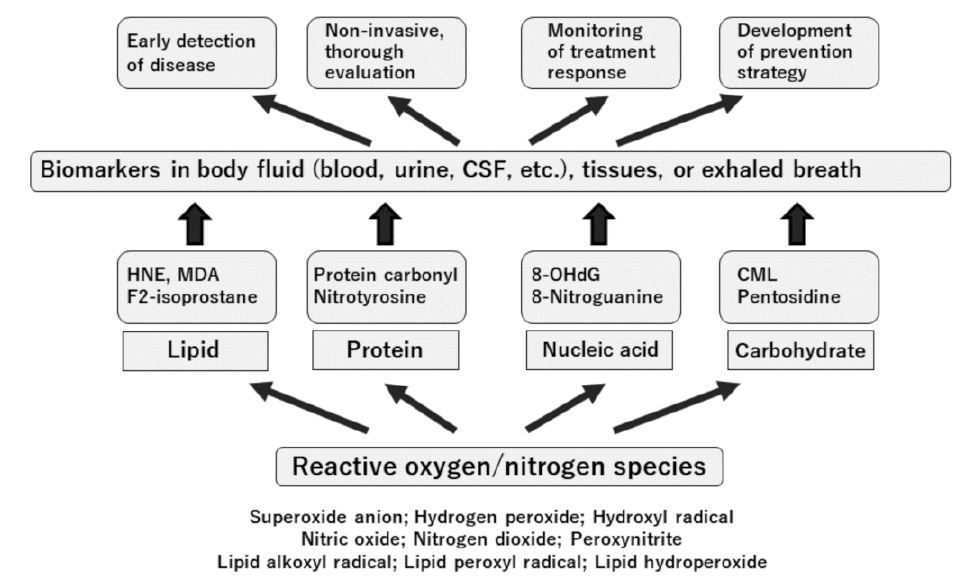
Figure 3. Perspective on the clinical use of oxidative stress biomarkers. Abbreviations: CML, carboxymethyl lysine; CSF, cerebrospinal fluid; HNE, 4-hydroxy-2-nonenal; MDA, malondialdehyde; 8-OHdG, 8-hydroxy-2 (cid:48) -deoxyguanosine. Only the representative markers are presented